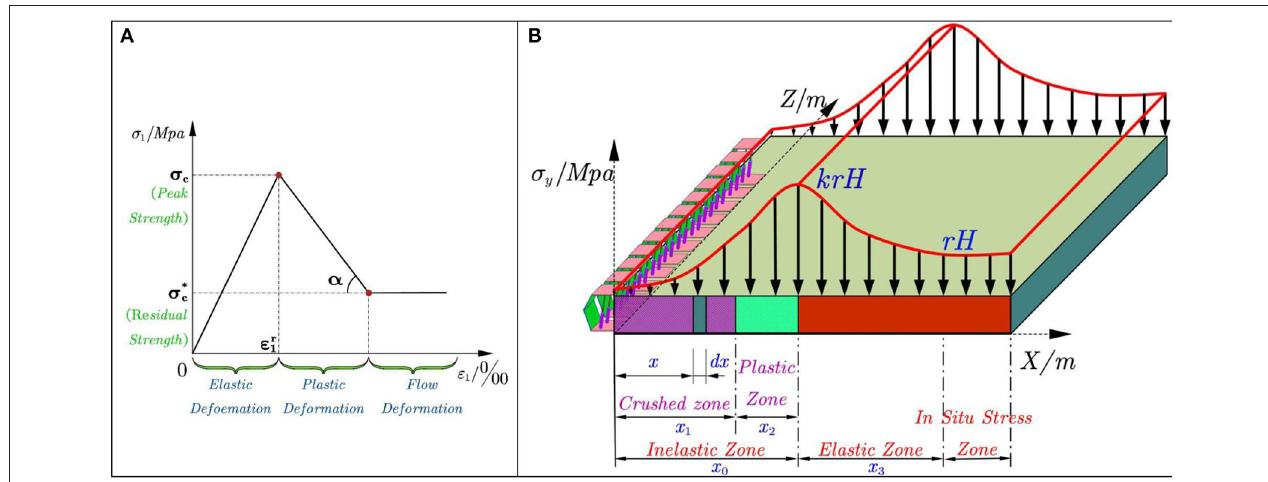
FIGURE 2 | Elastic-plastic strain-softening model and abutment pressure distributions. (A) Elastic-plastic strain-softening model. (B) Distribution law of advance bearing pressure on the working face.